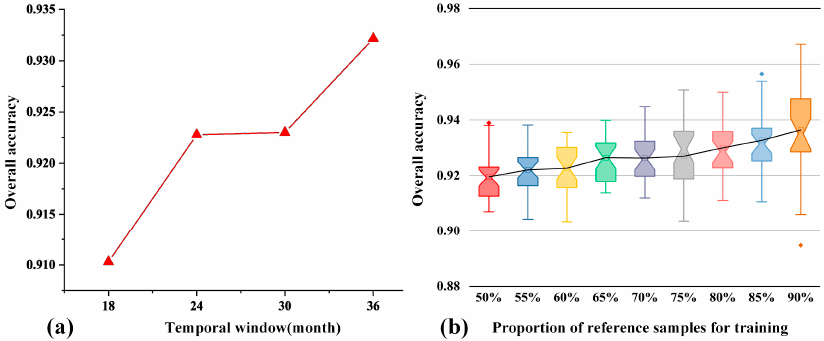
Figure 9. The relationship between the overall accuracy and (a) different temporal windows as well as (b) the proportion of reference sample points for training, respectively.